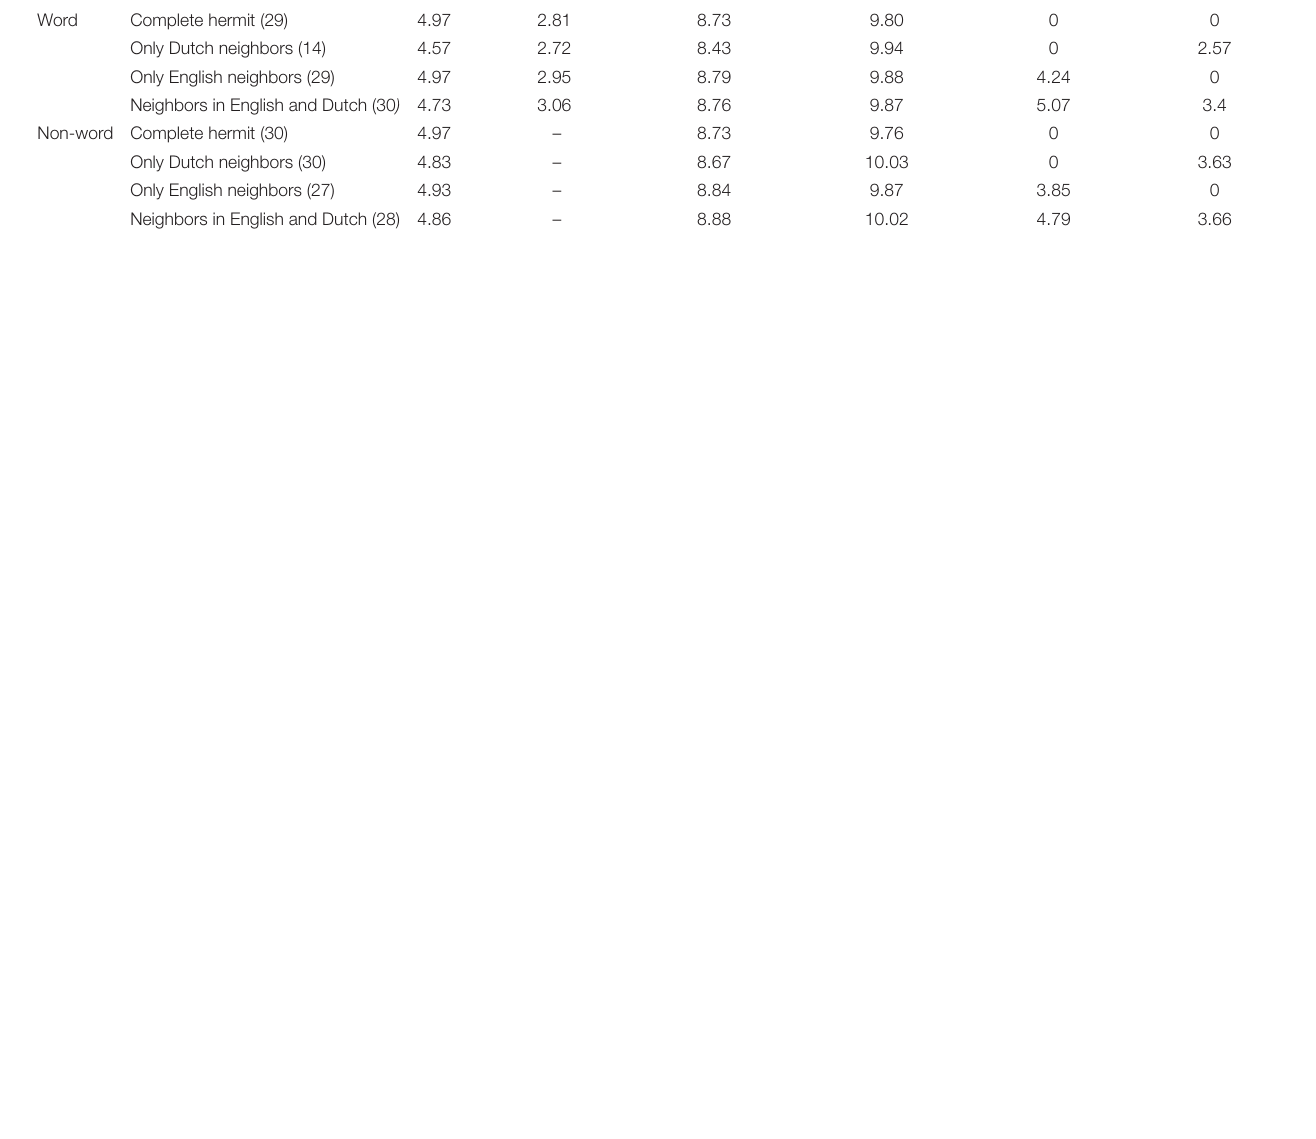
TABLE A1 | Characteristics of the word and non-word items in Experiments 2 and 3 (data entered into the analysis). Stimulus